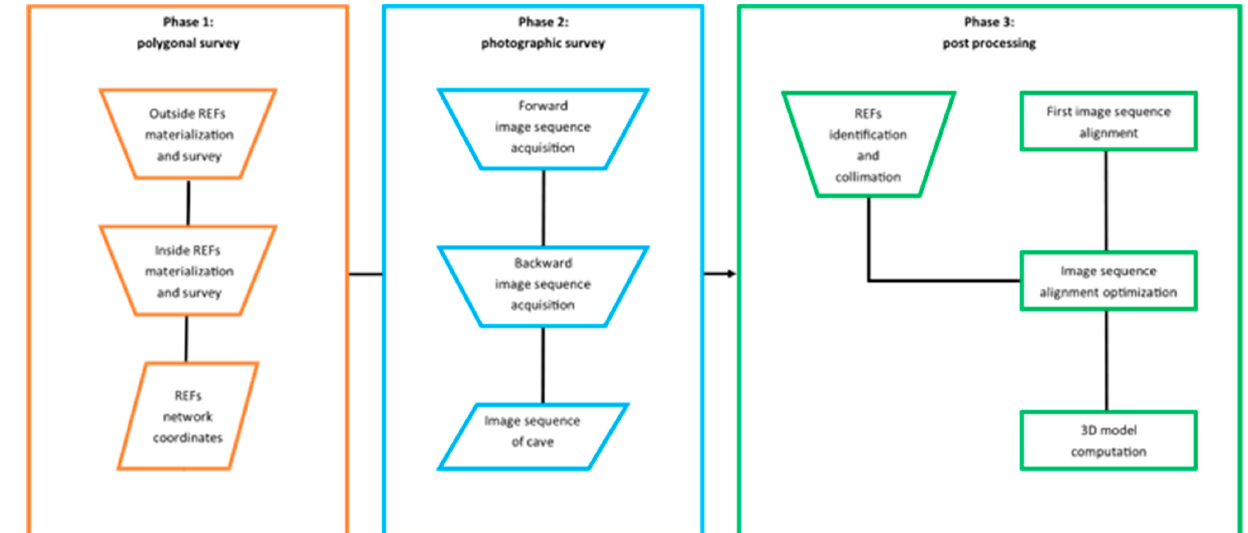
Figure 3. workflow of the proposed methodology. Figure 3. Workflow of the proposed